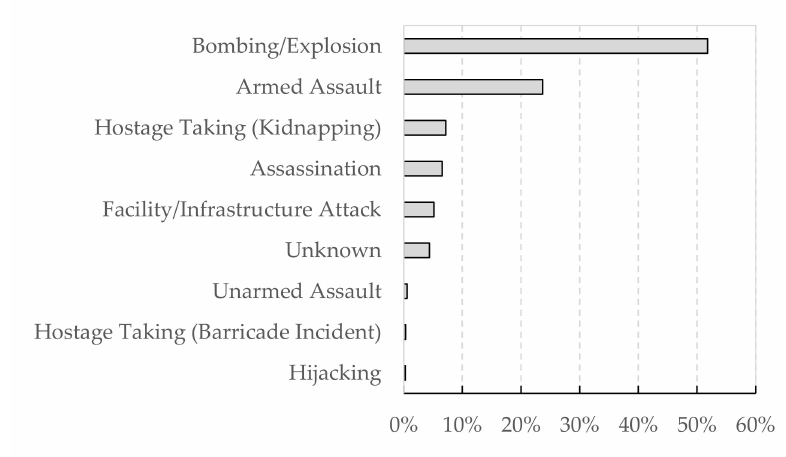
Figure 1. Percentages of terrorist attack types, based on data from [1].